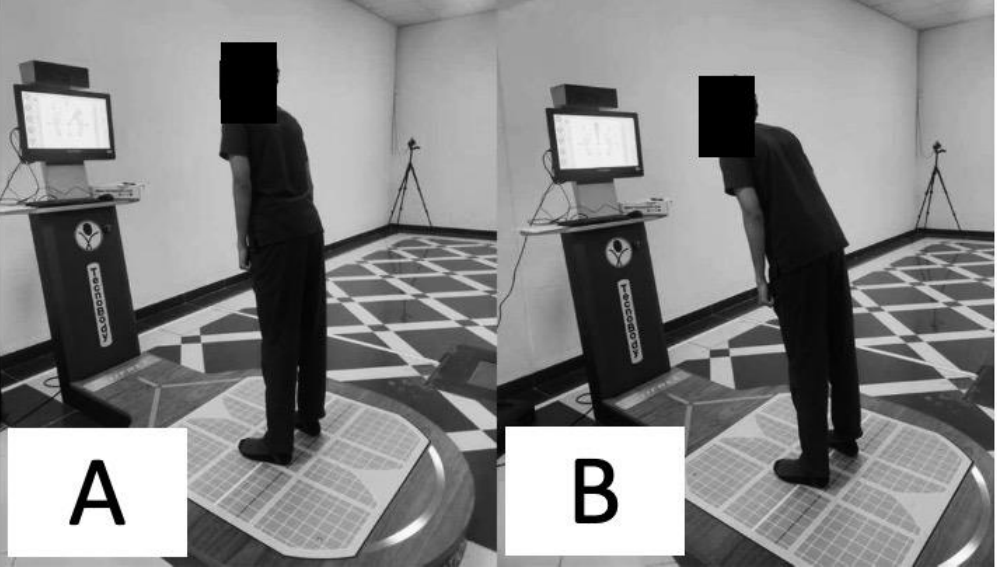
Figure 2. Limits of stability assessment ( A ) starting and ( B ) moving to a